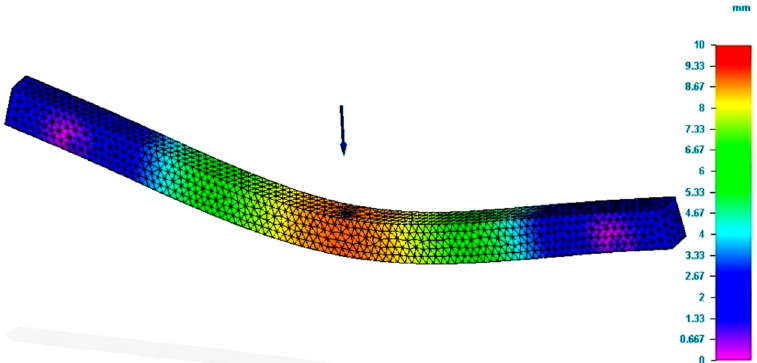
Figure 4. Results of simulation process for P_R12 specimen (total deformation values).